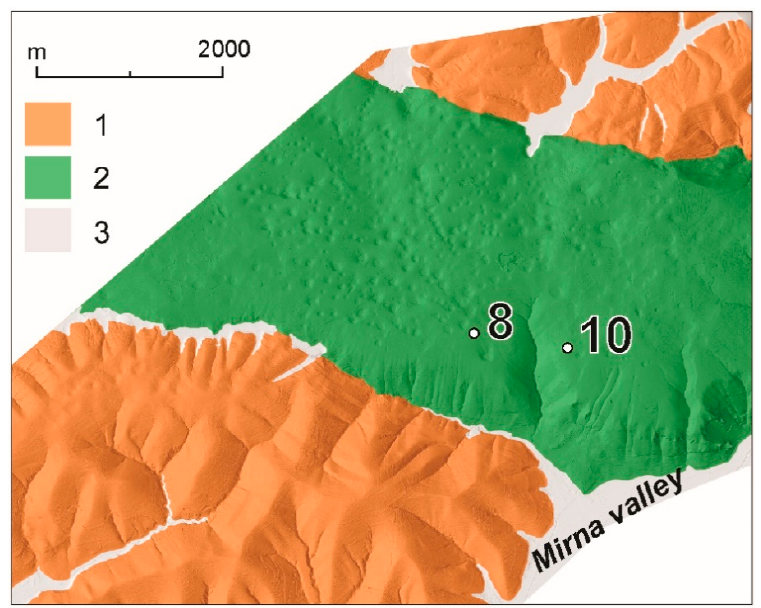
Figure 2. Position of features 8 and 10 and geological map of the investigated area. 1: Flysch deposits (Eocene); 2: Rudist limestone, dolomite and breccia (Cretaceous); 3: Quaternary deposits (mainly Holocene). Modified after Felja et al. [24].